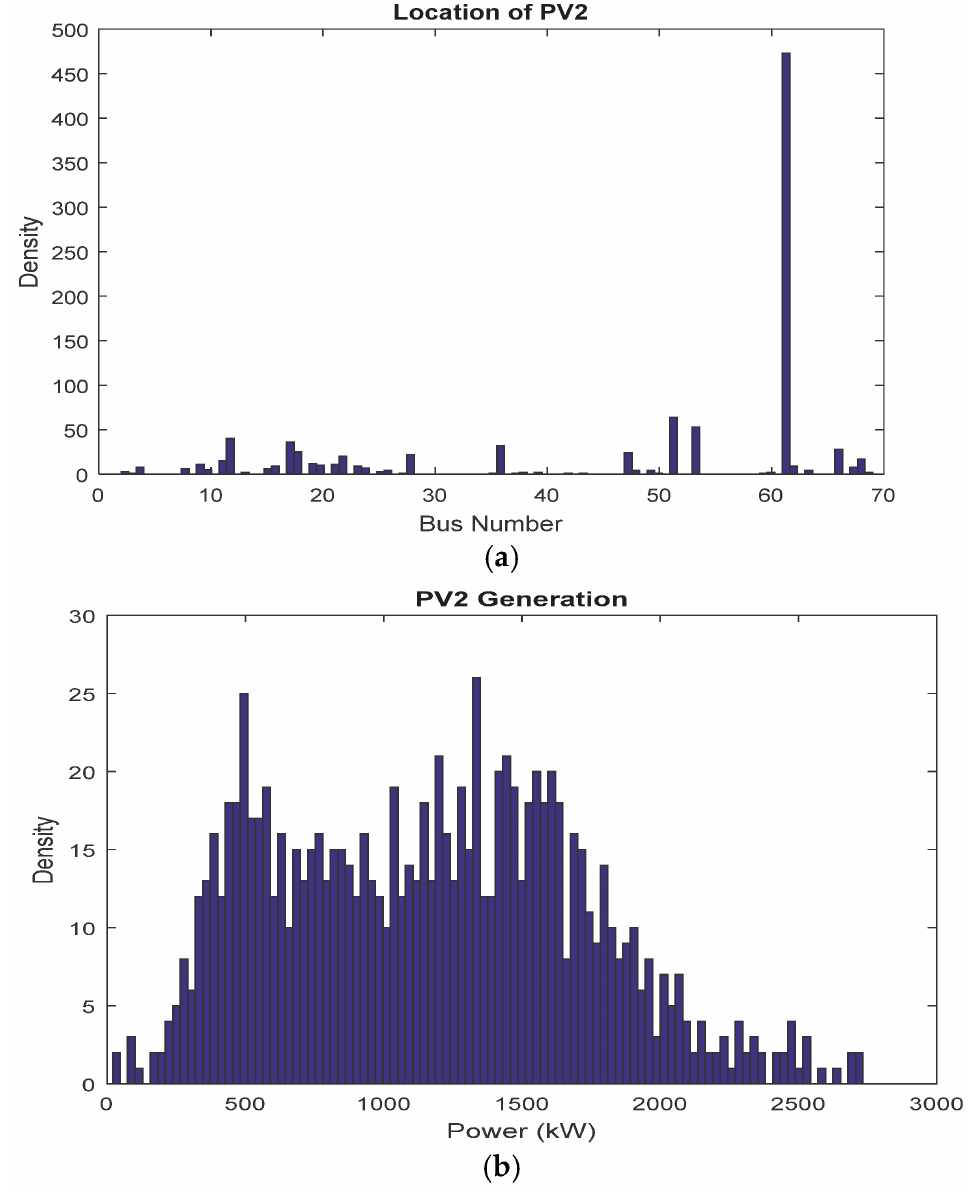
Figure 16. The PDF of placement and size of 2nd PV in the 69-bus system with uncertainties using IHLOA: ( a ) location of 2nd PV; ( b ) 2nd PV